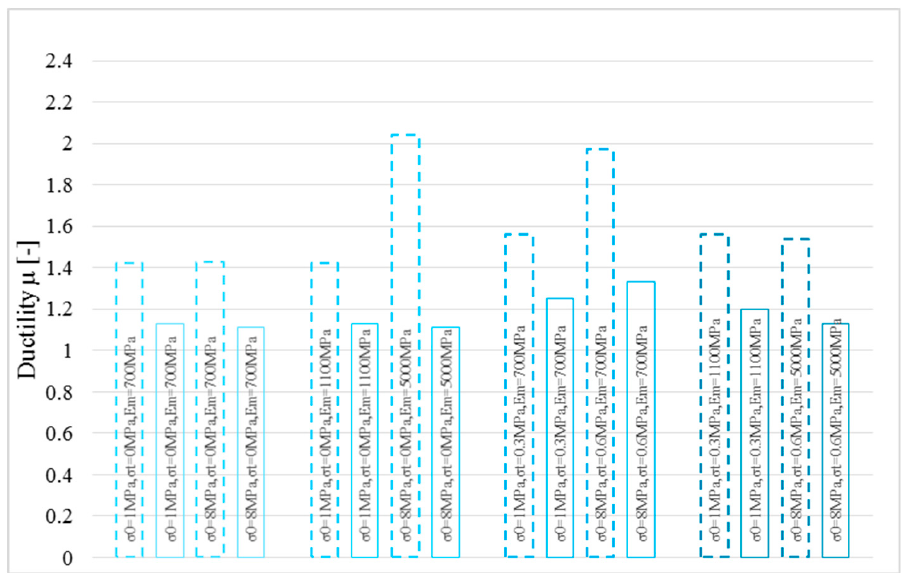
Figure 13 . Bi-linearized M- χ curves: P = 0 N, σ 0 = 8 MPa, σ t = 0 and 0.6 MPa, E m = 700 and 5000 MPa for tri-linear (solid lines) and bi-linear (dotted lines) relationships for the strengthening system (hemp fiber).